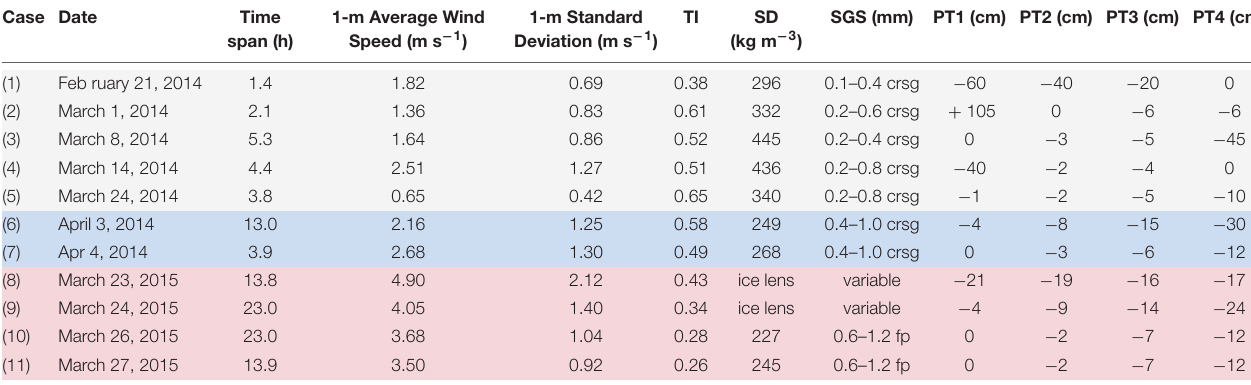
TABLE 1 | Case numbers, associated dates and sensor heights relative to the snow surface for each deployment.